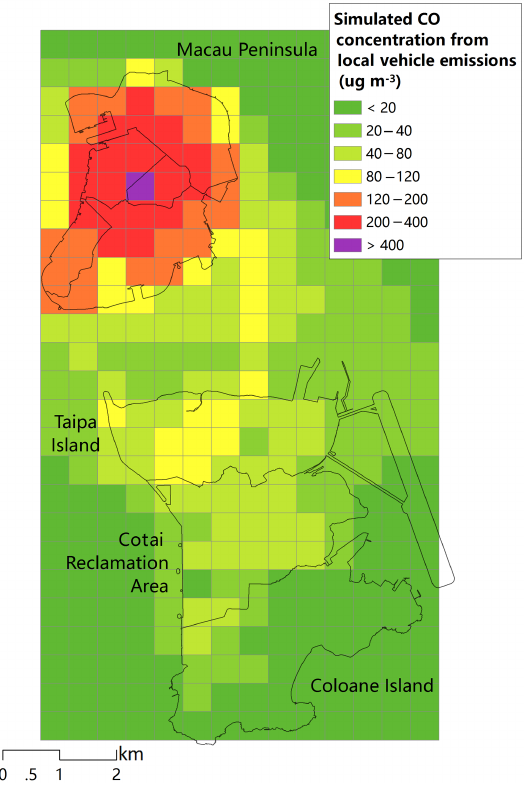
Figure 7. Simulated vehicle-contributed concentration of CO in Macau during weekdays in November